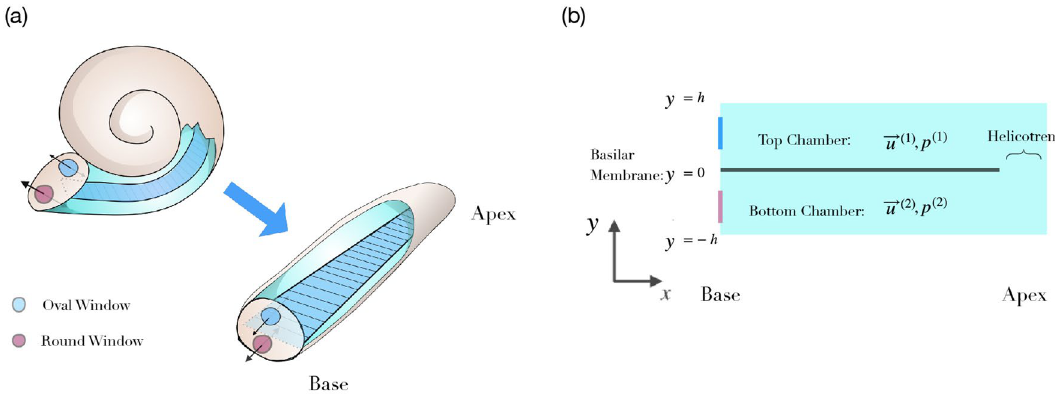
Figure 1. The morphology of the inner ear. ( a ) The cochlea is a spiral-shaped duct filled with fluid and segregated into two chambers by the elastic basilar membrane (dark blue), which can be accessed through the round and the oval windows at the base. Mathematical descriptions of the fluid dynamics typically consider the simplification of an uncoiled, linear cochlea. ( b ) Many aspects of cochlear fluid dynamics can be captured in a two-dimensional representation, in which one dimension, x , represents the inner ear’s longitudinal extent and the other dimension, y, denotes the vertical deviation from the basilar membrane. We further denote by u ( 1 ) and p ( 1 ) the velocity and the pressure in the upper chamber. Analogously, u ( 2 ) and p ( 2 ) are the